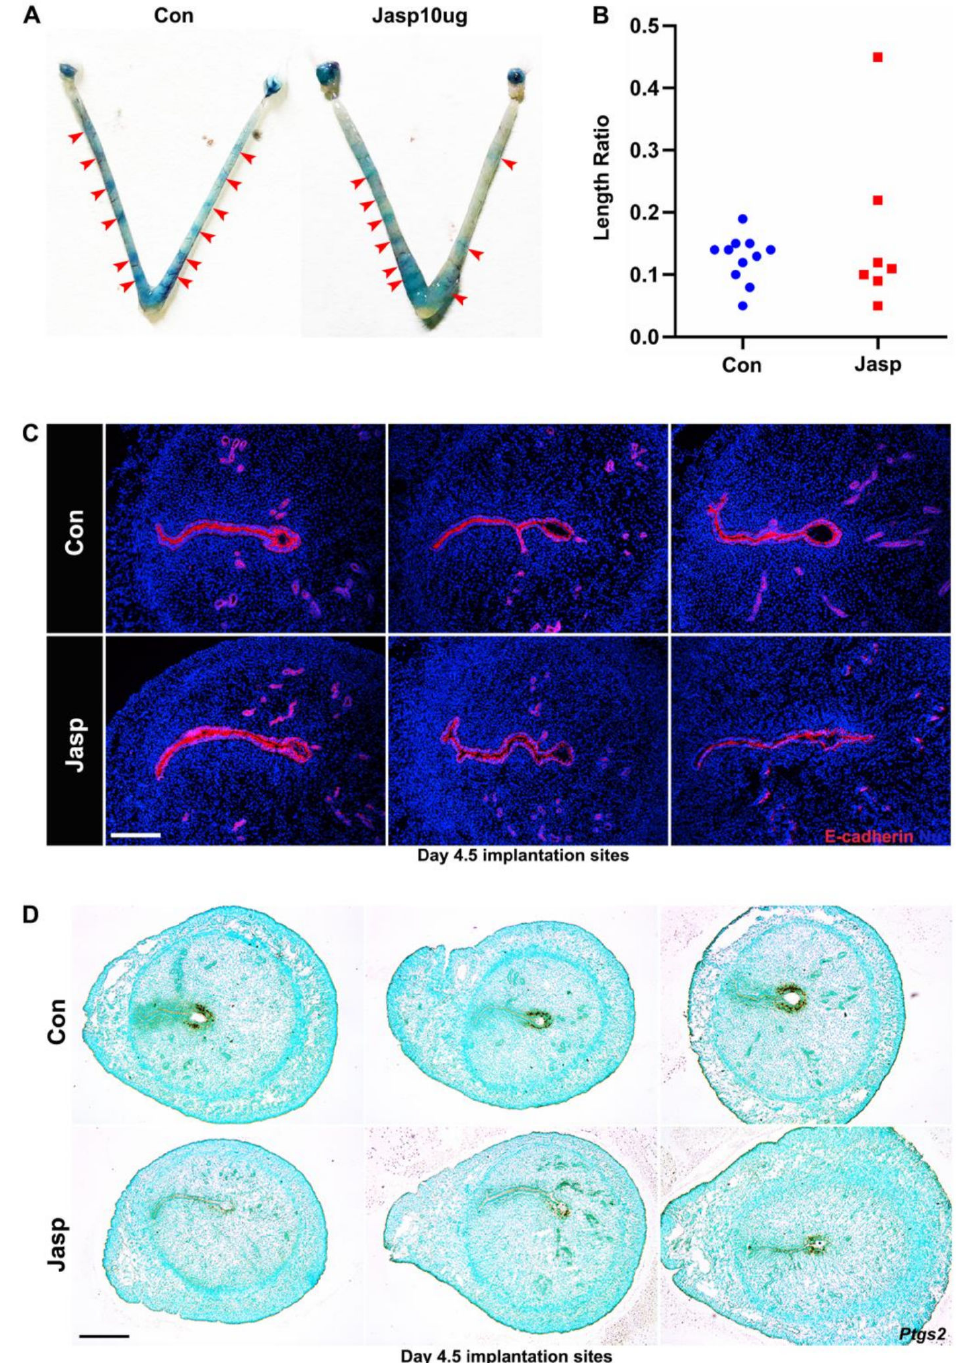
Figure 3. Abnormal embryo implantation on day 4.5 of pregnancy after Jasp treatment. ( A ) The mice were intraperitoneally injected with Jasp 10 µ g/mice on day 3 of pregnancy, and embryo distribution was observed on day 4.5 of pregnancy (red arrows). ( B ) The ratio of embryo interval distance to full uterine length on day 4.5 of pregnancy. More than 6 mice were studied for each group. ( C ) Abnormal embryo morphology on day 4.5 of pregnancy, E-cadherin (red) labeled epithelial cells, DAPI (blue), with three replicates in the figure. Scale bars = 200 µ m. ( D ) In situ hybridization results for Ptgs2 on day 4.5 of pregnancy, with three replicates in the figure. Scale bars = 500 µ